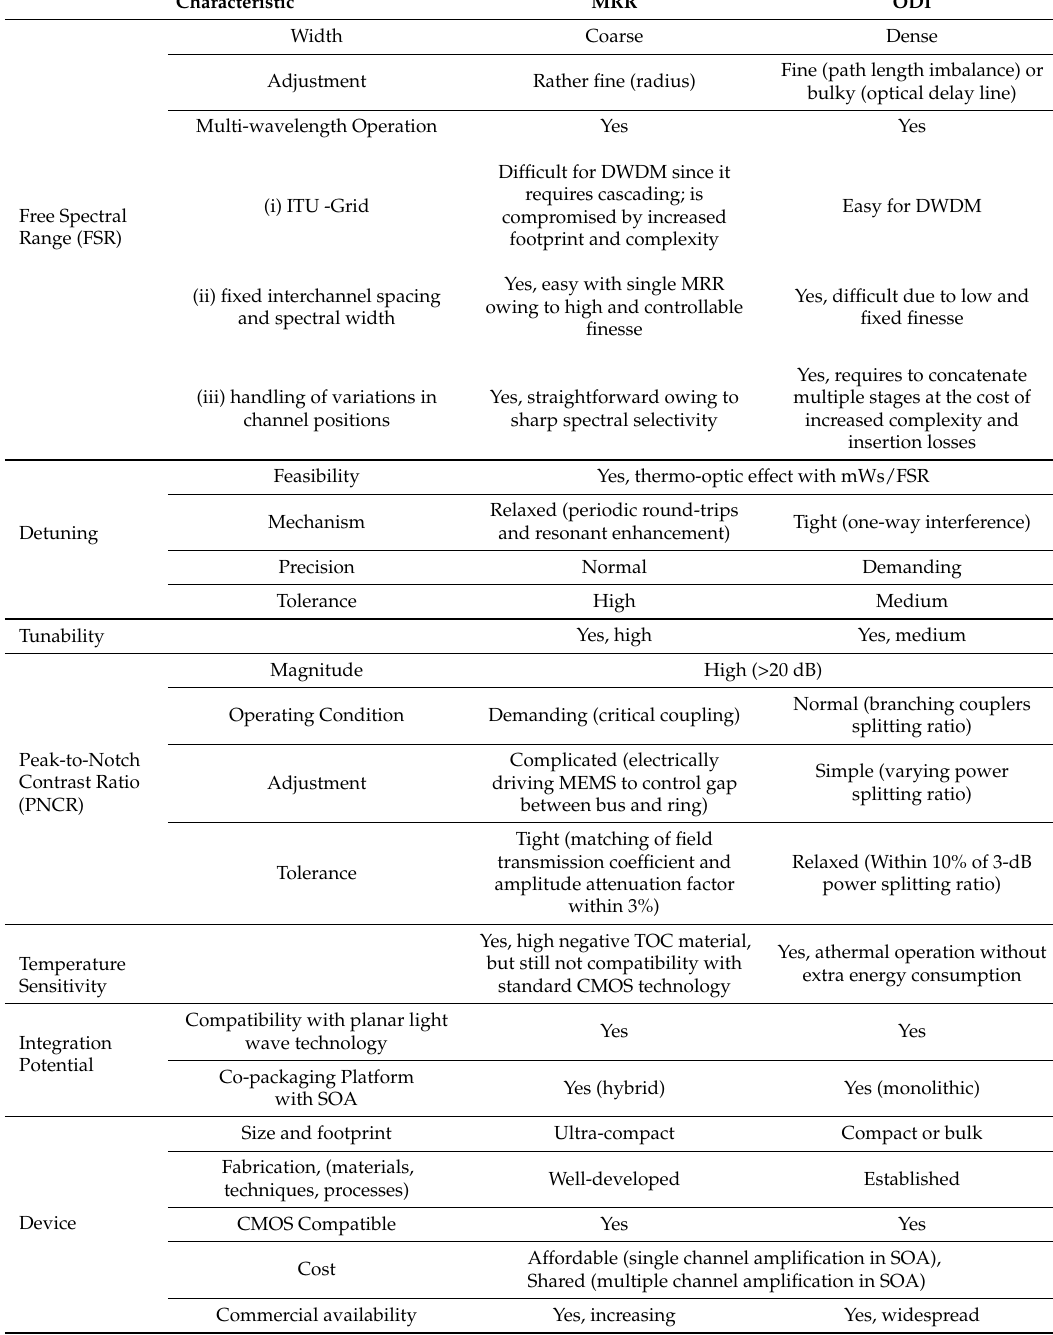
Table 2. Qualitative comparison of MRR and ODI key